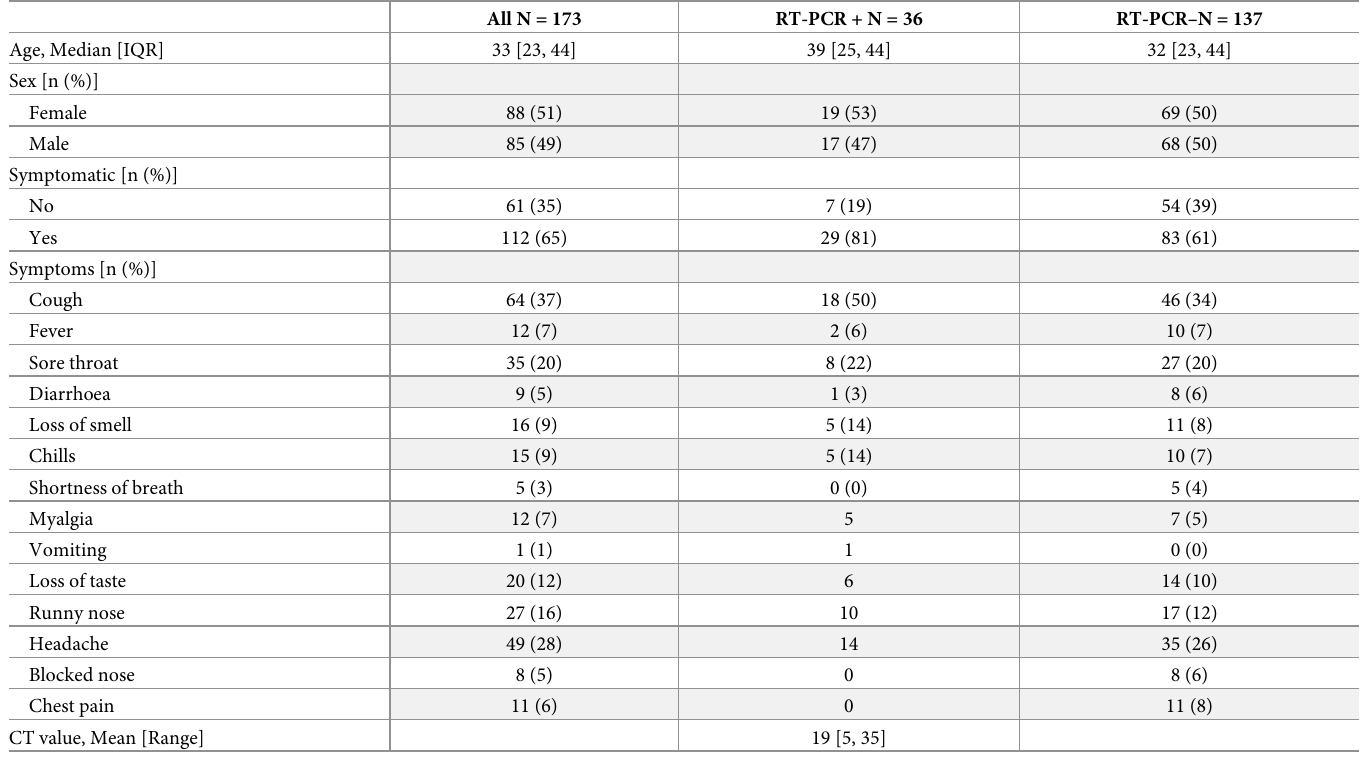
Table 3. Demographics and clinical characteristics of participants.